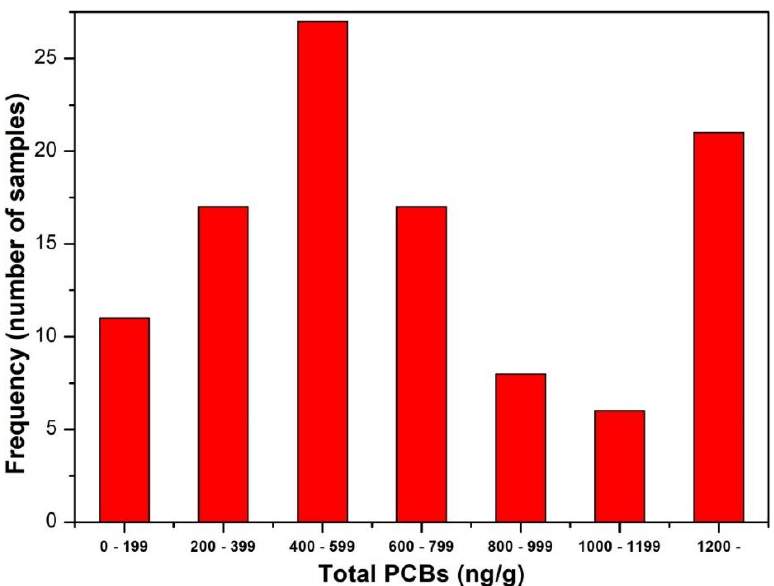
Figure 4. Frequency distribution of the concentrations of total PCBs in human fat tissue.